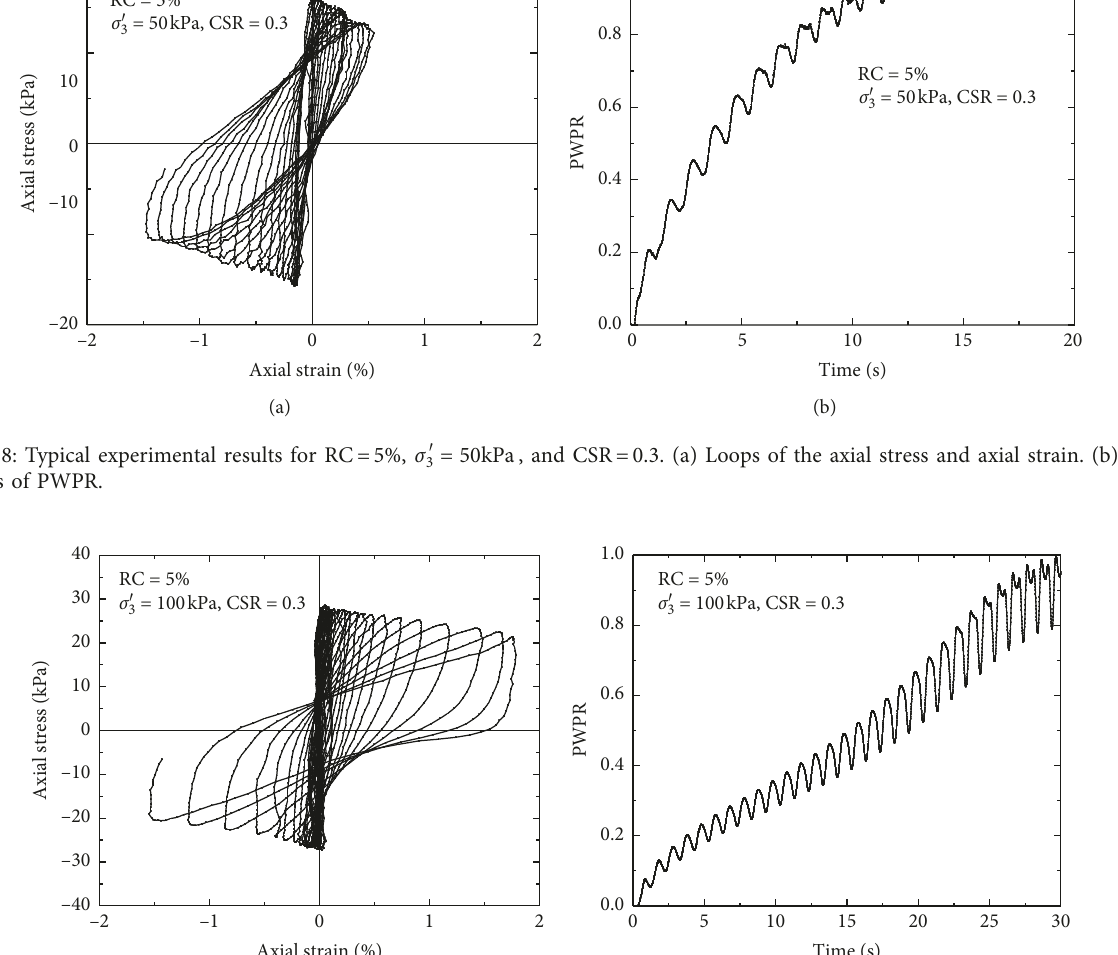
′ � 50 � 100kPa, and CSR � 0.3. (a) Loops of the axial stress and axial strain. (b) Time 3